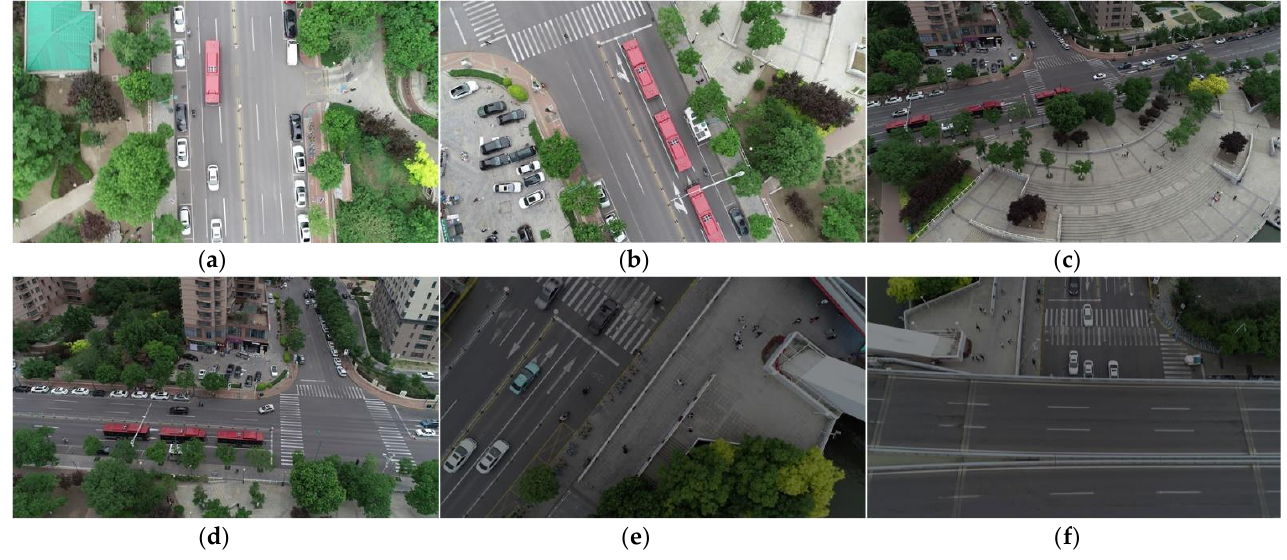
Figure 4. Examples of UAV-captured image data. ( a , b ) are image samples captured under excellent imaging luminance. ( c , d ) Image samples captured under ordinary imaging luminance. ( e , f ) Image samples captured under severe imaging luminance.